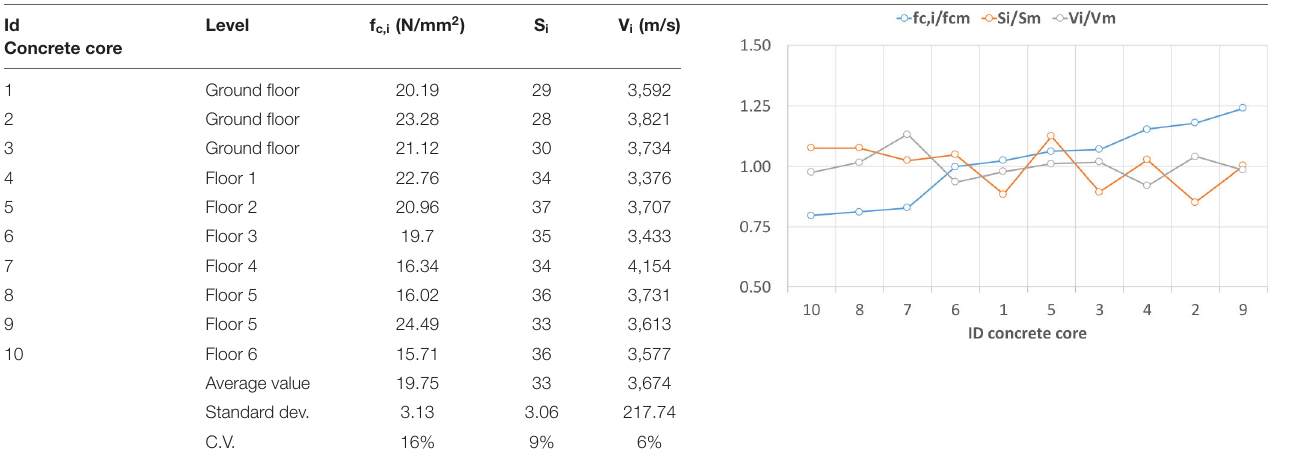
TABLE 2 | Compressive strength of the extracted cores and results of the non-destructive tests conducted. Id Concrete